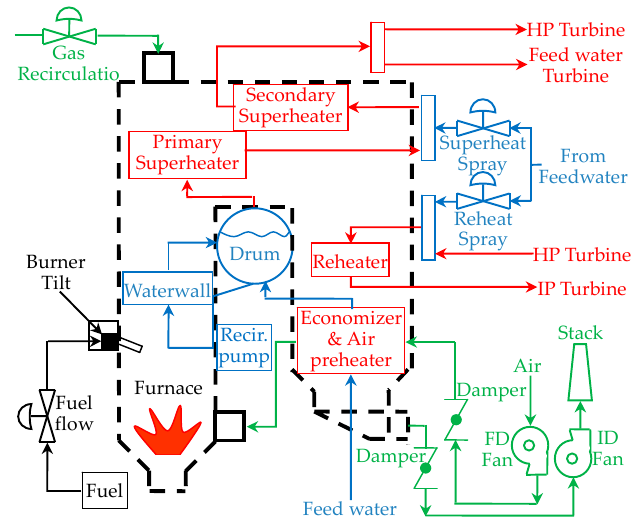
Figure 4. Boiler system of a 600-MW drum-type thermal power plant.